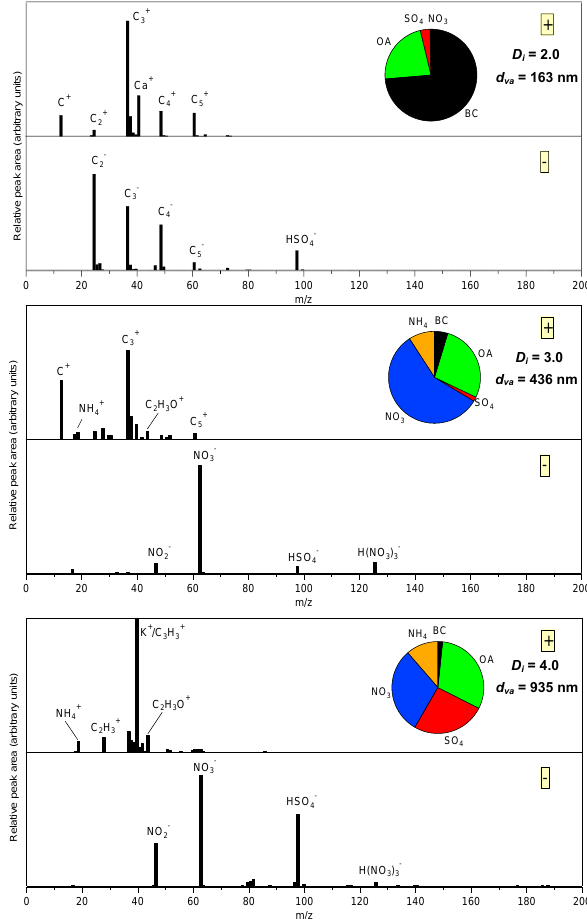
Figure 4. Example single particle mass spectra and chemical com- position estimates for particles with calculated D i values of 2.0 (top panel), 3.0 (middle panel) and 4.0 (bottom